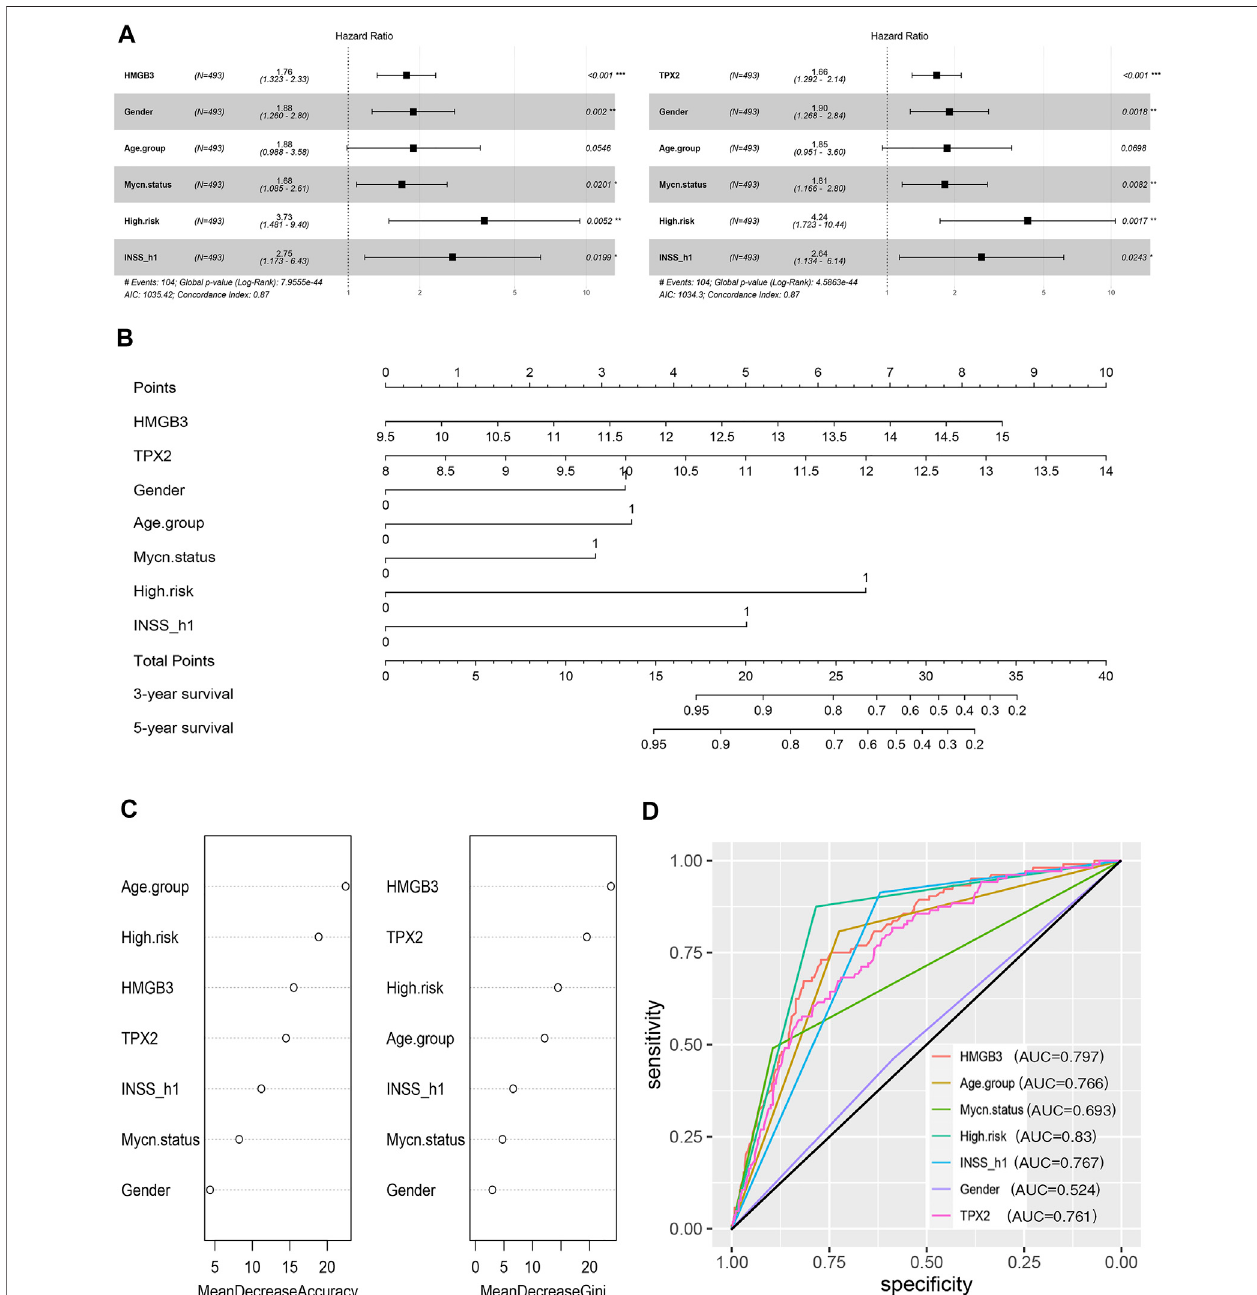
FIGURE 7 | HMGB3 and TPX2 are closely associated with the survival of patients with NB in GSE49710. (A) HMGB3 and TPX2 can be independent prognostic factors for overall survival. (B – D) Nomogram, random forest, and ROC curves of HMGB3, TPX2 and clinicopathological characteristics for NB patients.